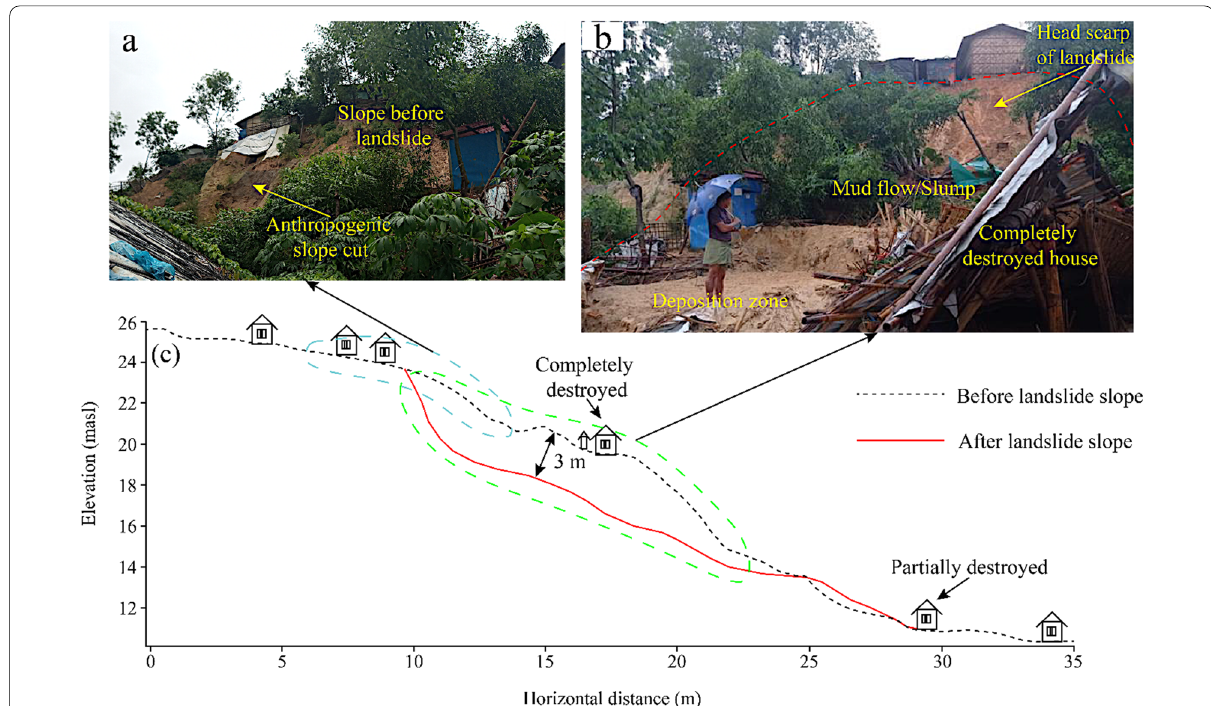
Fig. 7 a and b landslide features and damages, and c schematic profile of the landslide slope along the A-A ´ line shown in Fig.